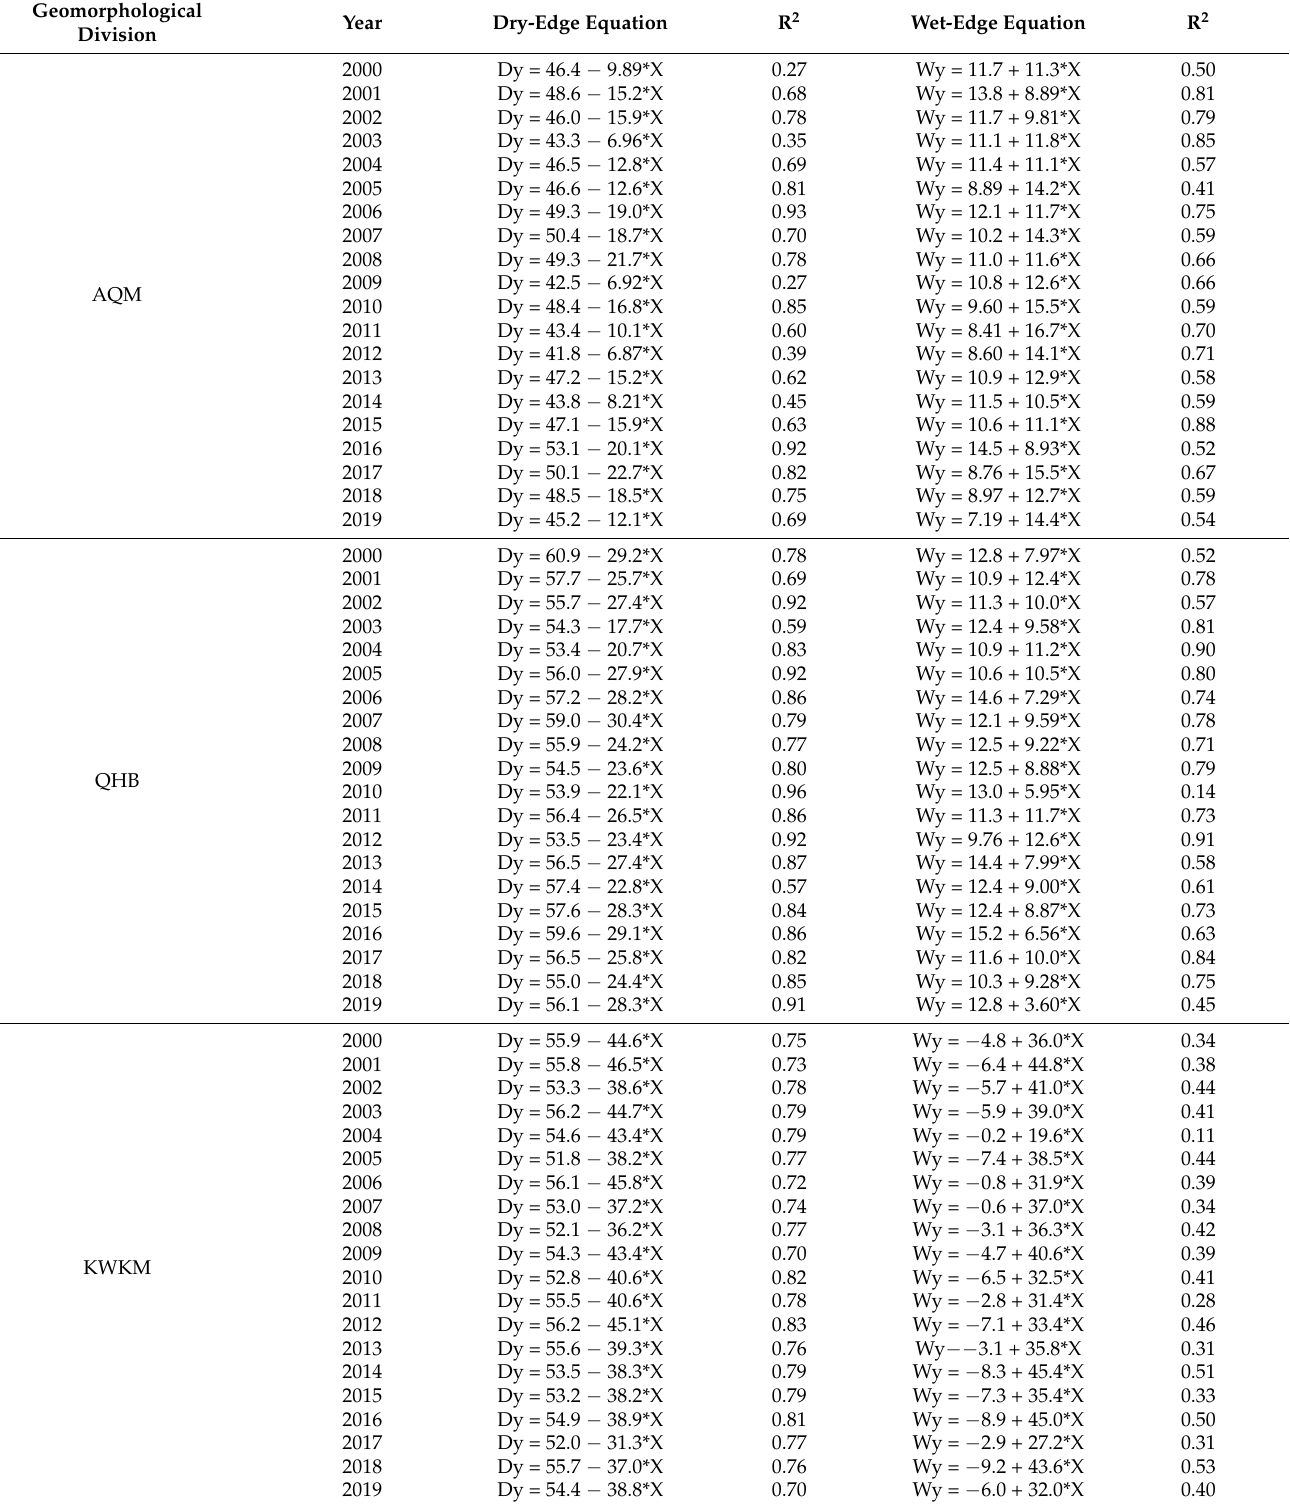
Table A3. Dry-edge and wet-edge equations of eight geomorphological divisions from 2000 to 2019. Geomorphological